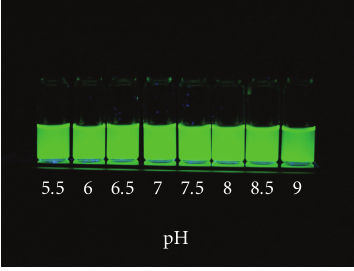
Figure 2: Gel shift of 510-nm emitting CdSe–ZnS QD’s coated with di ff erent ligands in 1.5% agarose gel bu ff ered with TBE bu ff er: (A,E) DHLA; (B) DHLA–PEG600; (C) DHLA: DHLA–TEG–Biotin